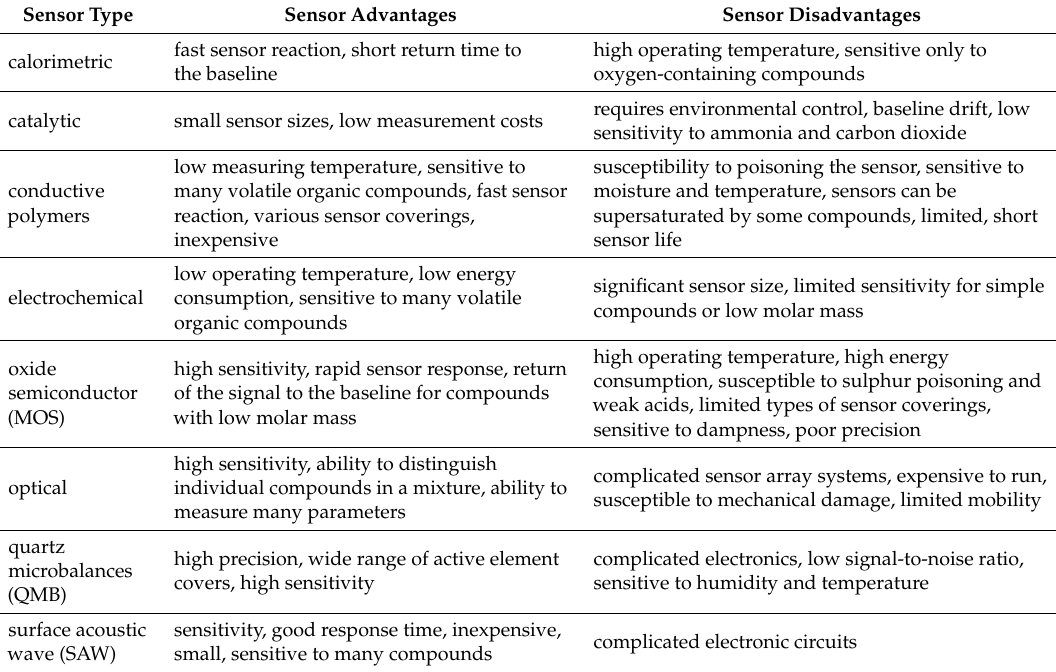
Table 1. General characteristic of most commonly applied gas sensors